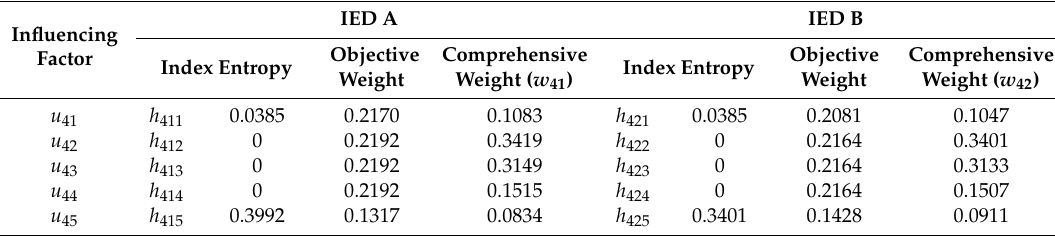
Table 22. The objective and comprehensive weights of the influencing factors of IED A and IED